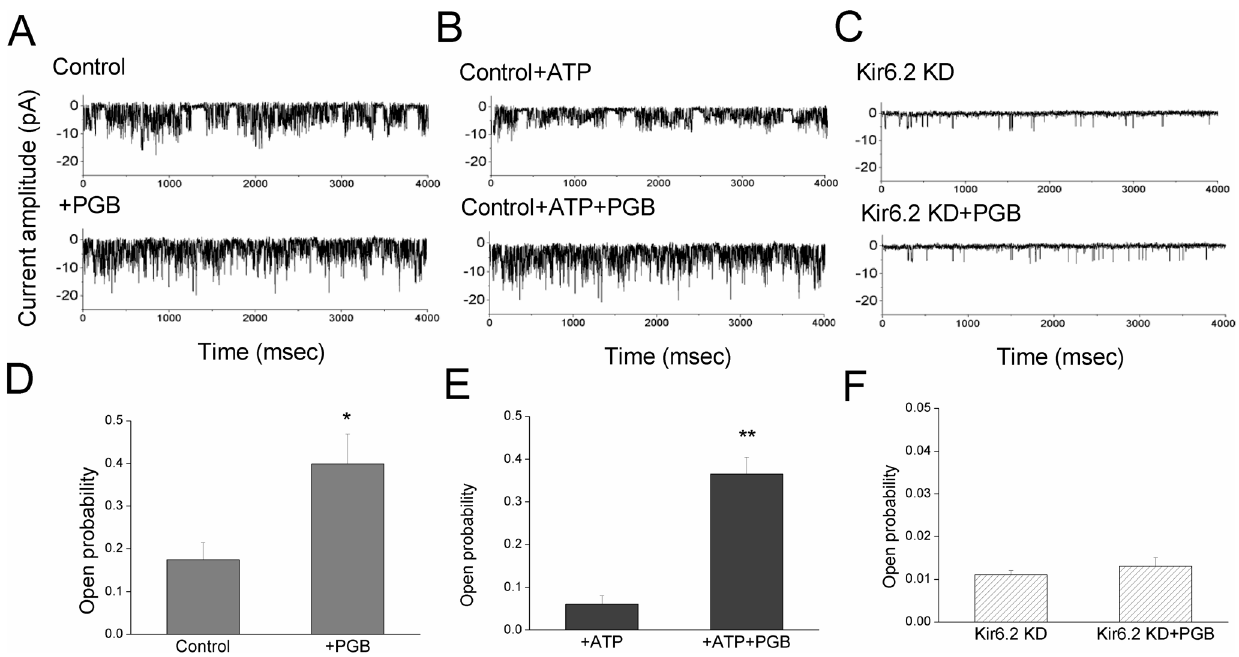
Figure 7. PGB significantly opened K ATP in the presence of a high concentration of ATP. A hippocampal-derived H19-7 neuronal cell line stably expressing Kir6.2 and the SUR1 subunit was transfected with siRNAs targeting Kir6.2. The cells were immersed in a symmetrical K + (145 mM) solution (holding potential = 2 60 mV). Inside-out configuration in patch clamp technology was used. A, C: Control neurons showed more channel activities (0.174 6 0.043) than the RNAi Kir6.2 knockdown (KD) neurons did (0.013 6 0.002). PGB (50 m M) significantly ( p , 0.05) increased the channel activities to 0.399 6 0.068 in control neurons, but did not increase the channel activities in the Kir6.2 KD neurons (0.014 6 0.001). B: ATP (1 mM) significantly ( p , 0.05) attenuated the channel activities in control neurons (0.061 6 0.025). B, E: Adding PGB (50 m M) to ATP (1 mM) showed significant increases in channel activity in control neurons (0.365 6 0.041). D–F: In control neurons, the difference in opening probabilities between neurons treated with PGB + ATP and ATP alone was even higher and more significant ( p , 0.01) than that between neurons treated with PGB alone and